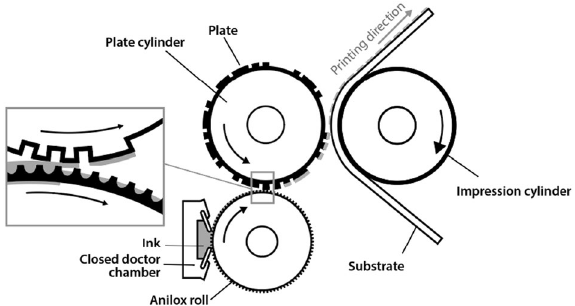
Fig. 4 Flexographic press principle. The inked pattern is pressed against the polyethylene terephthalate substrate in the nip zone between the printing form and an impression